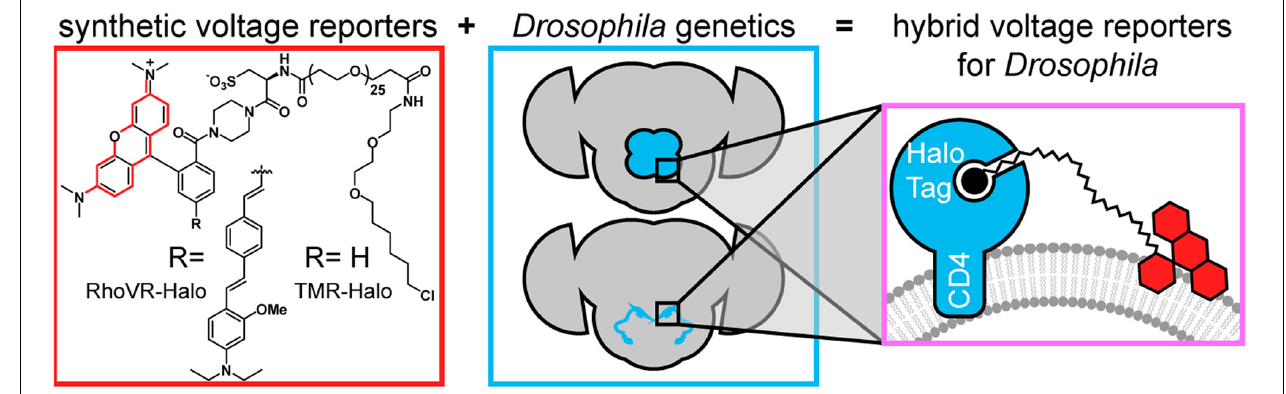
FIGURE 1 | Chemical-genetic hybrids for voltage imaging in Drosophila . (red box) Chemically synthesized rhodamines with chloroalkane ligands will form covalent adducts with HaloTag enzymes. When the functional group R is the indicated molecular wire, the resulting RhoVR-Halo is voltage-sensitive. When R is H, the tetramethyl rhodamine-Halo is not voltage-sensitive (TMR-Halo) (teal box). The use of GAL4-UAS fly lines enables selective expression of HaloTag enzymes in defined populations of neurons. (magenta box) When HaloTag is fused with CD4, expression on the cell surface of defined neurons allows in vivo labeling (with either TMR-Halo or RhoVR-Halo) followed by ex vivo voltage imaging (with RhoVR-Halo).